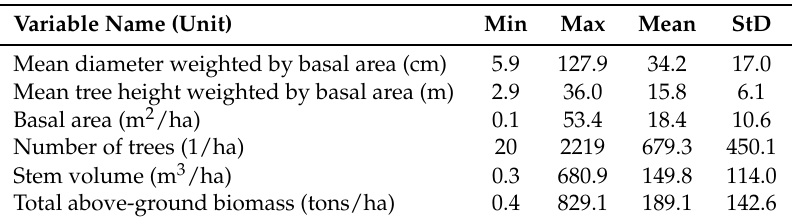
Table 2. Statistics of the field data (712